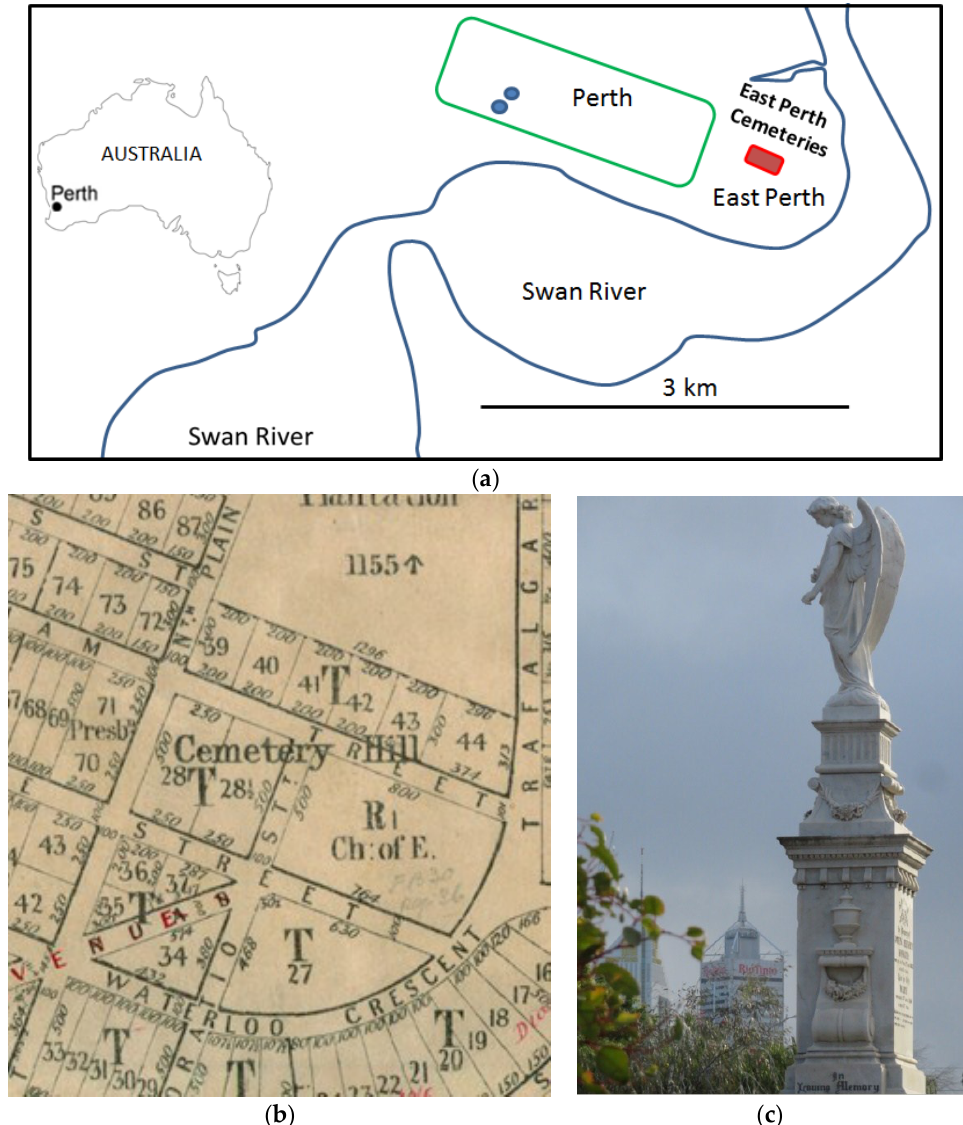
Figure 1. The East Perth cemetery complex: ( a ) Location of the East Perth cemeteries in relation to the city of Perth (green) and Australia (inset); ( b ) Location of the seven contiguous East Perth cemeteries relative to each other at the end of the nineteenth century (Lot R1; Lots T27,28,28½; T39–44; T69–72). Source: State Records Office of WA (n.d.), Reference Code AU WA S235-341, undated; ( c ) The East Perth Cemeteries are located on a hill, 2 km to the east of the depicted Perth central business district buildings (blue dots in ( a )). In the foreground is the Monger monument, East Perth Wesleyan Cemetery (Lot T28½). Photograph by S. Hayward (2017).